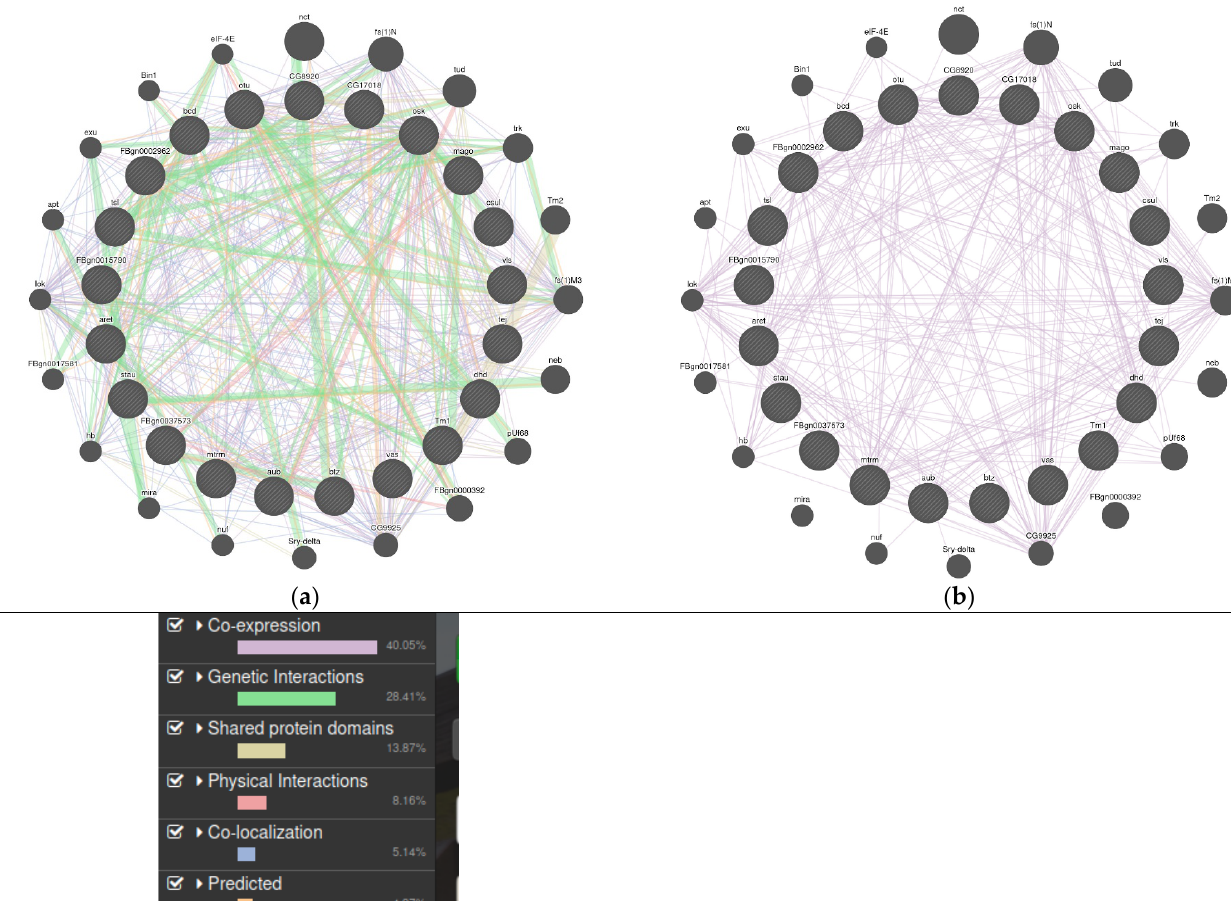
Figure 4. ( a ) A detailed protein–lncRNA interaction map generated using GeneMania that shows physical interactions, co-expression, co-localization, pathways, and genetic interactions in different edge colors (Supplementary file) The genes were queried using GeneMania with Drosophila melanogaster as a query producing the candidate nodes shown to be interacting with others. ( b ) A co-expression interaction network of lncRNAs in insects. The edges (in pink color) indicate the co-expression between these lncRNAs and their interacting partners. It is likely that all co-expressed interactants are co-localized. Approximately 40.05% of interactions were associated with co-expression (please see legend below the figure).